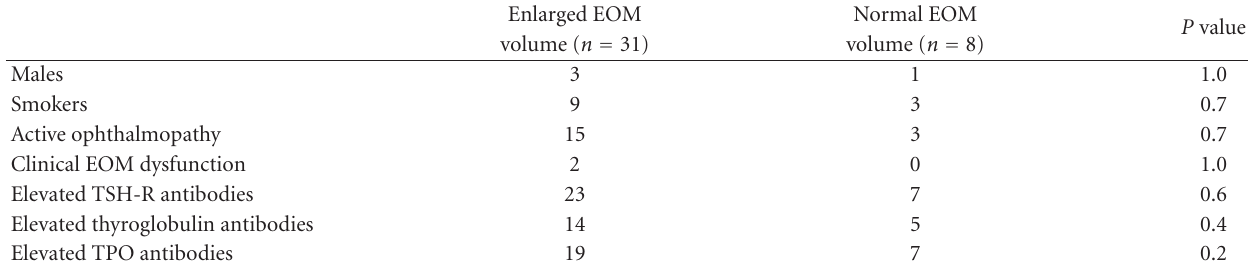
Table 1: Comparison between patients with and without EOM volume enlargement. The number of patients is shown, and the proportions P value was calculated using Fisher’s exact test.